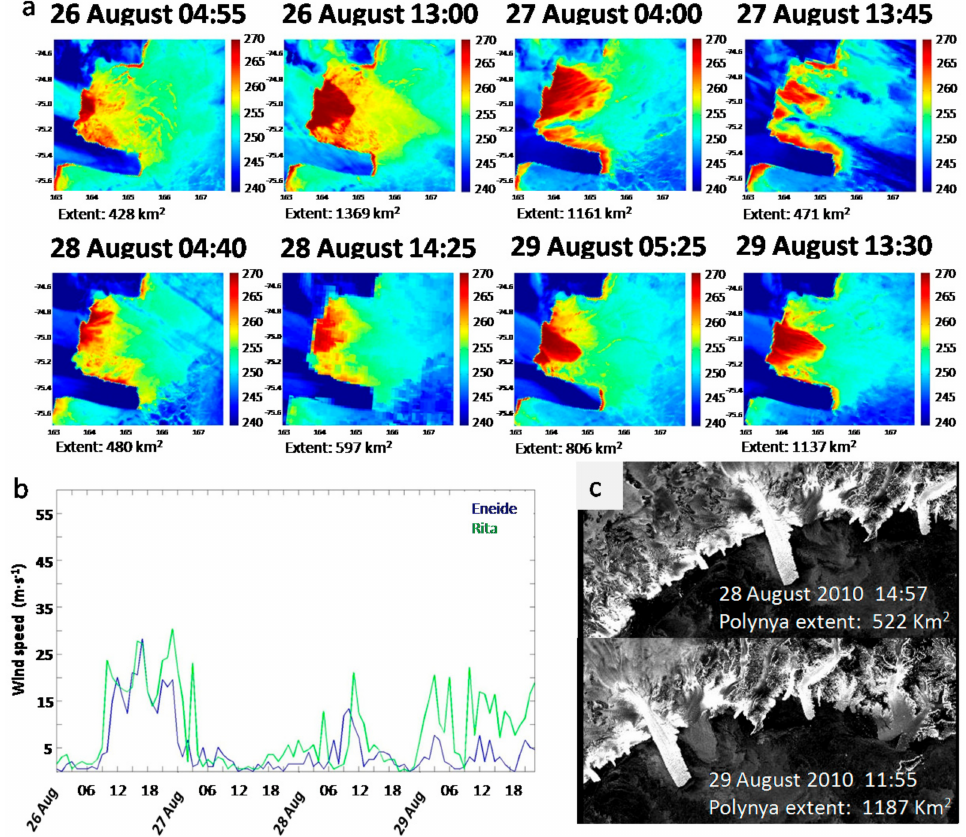
Figure 7. ( a ) Terra Nova Bay polynya extent variability between 26 and 29 August 2010 as seen through a selection of MODIS IST scenes; ( b ) AWS Rita (green) and Eneide (blue) wind records from 26 to 29 August 2010; ( c ) polynya extent retrieved through ENVISAT ASAR Wide Swath image acquired on 28 August 2010 at 14:57 and 29 August 2010 at 11:55 during ascending orbit 44,410—track 268 and orbit 44,424—track 282,